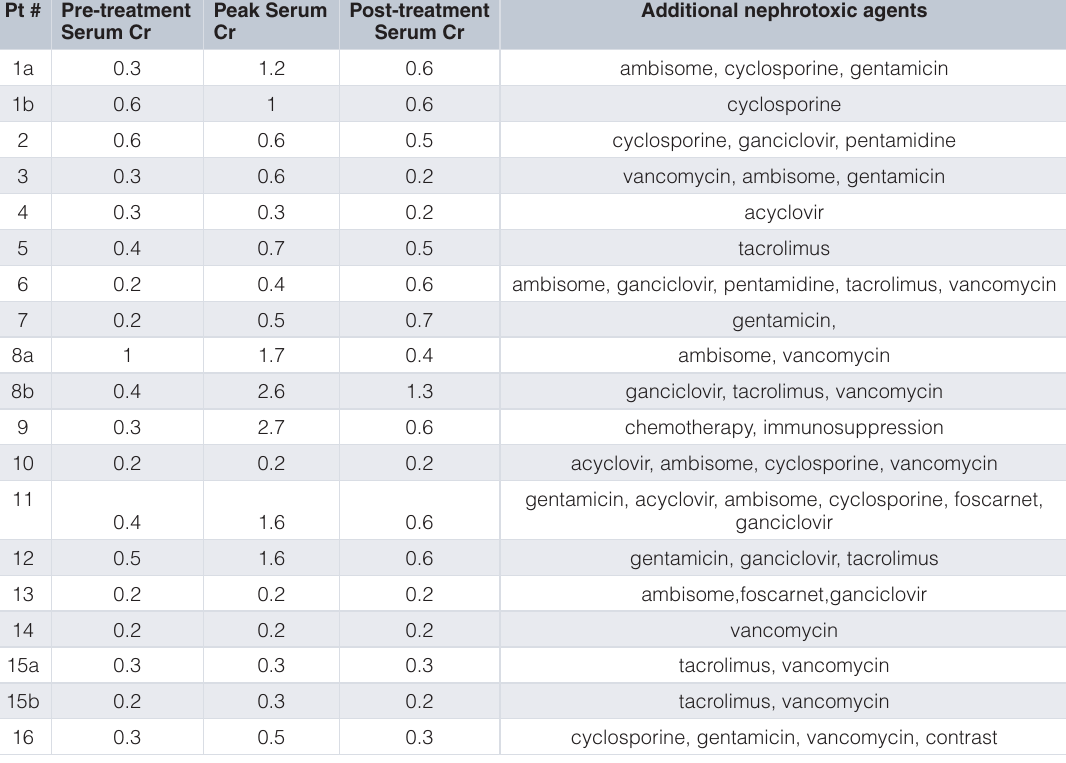
Table 2. Additional nephrotoxic agents prescribed and changes in serum creatinine during cidofovir therapy. Absolute values for serum creatinine in mg/dL for each patient are represented pre-treatment, during treatment (peak serum creatinine), and post-treatment. Additional nephrotoxic agents that each patient received are also represented.